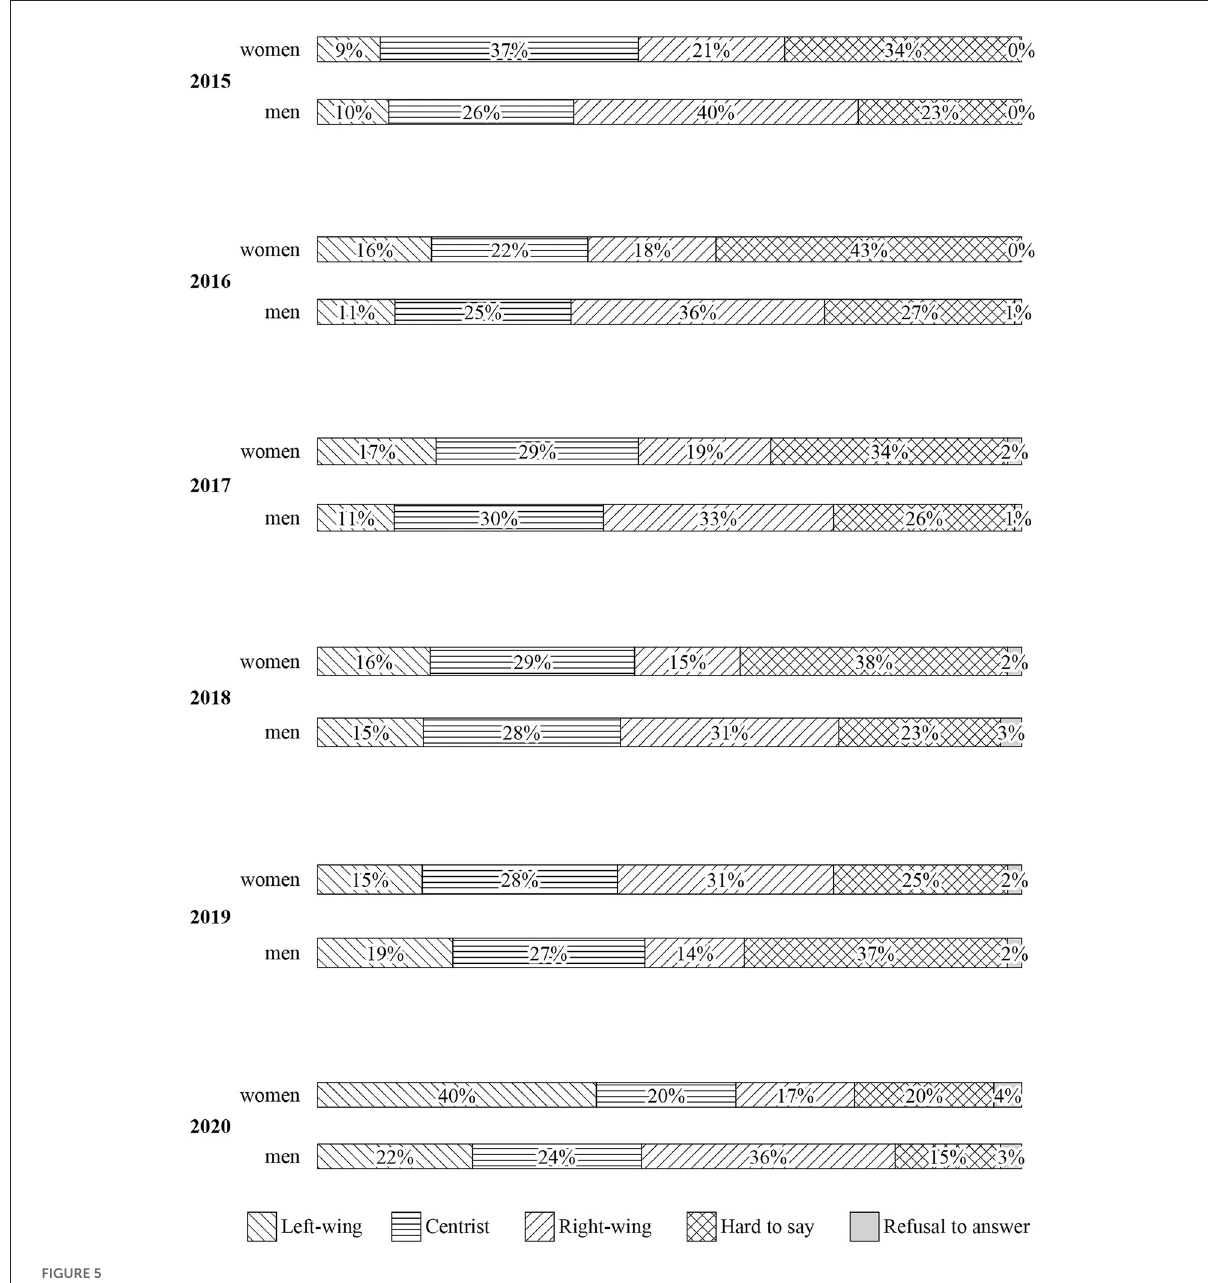
FIGURE5 Declared political views of men and women aged